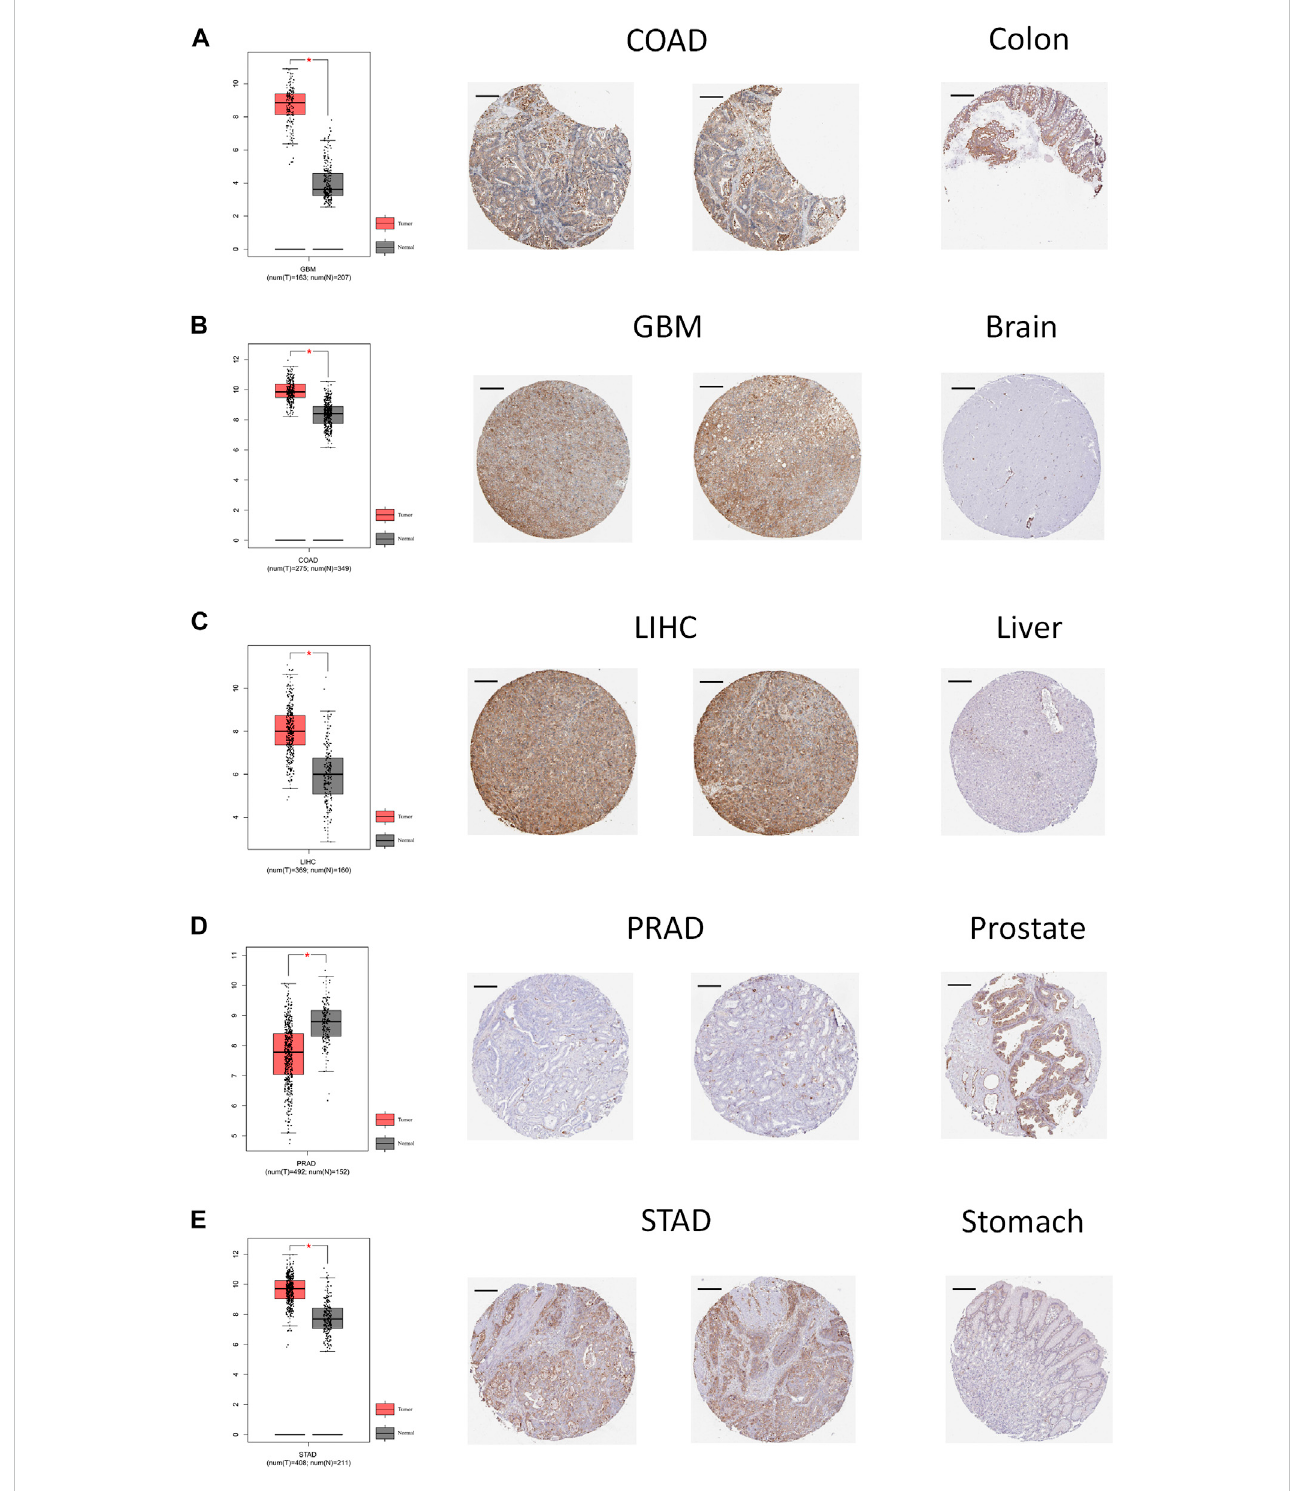
FIGURE 2 Comparison ofANXA2geneexpressionbetweentumorandnormal tissues(left)andimmunohistochemistryimages intumor(middle) andnormal(right) tissues. Comparison of ANXA2 gene expression between (A) COAD and colon, (B) GBM and brain, (C) LIHC and liver, (D) PRAD and prostate and (E) STAD and stomach. Scale bar = 200 μ m. * p <